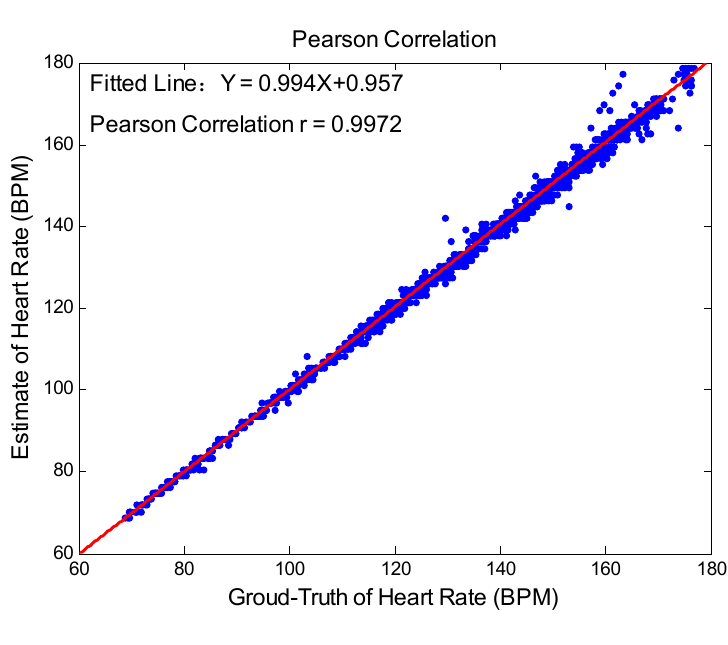
Figure 2. Bland-Altman plot.